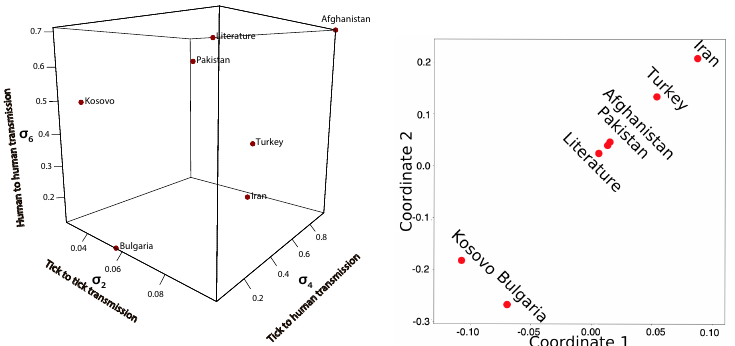
Figure 6. Scattered plot of the fitted transmission parameters and the values from the litera- tures [31,34,35,44] and the embedded multidimensional scaling plot of the fitted parameters.